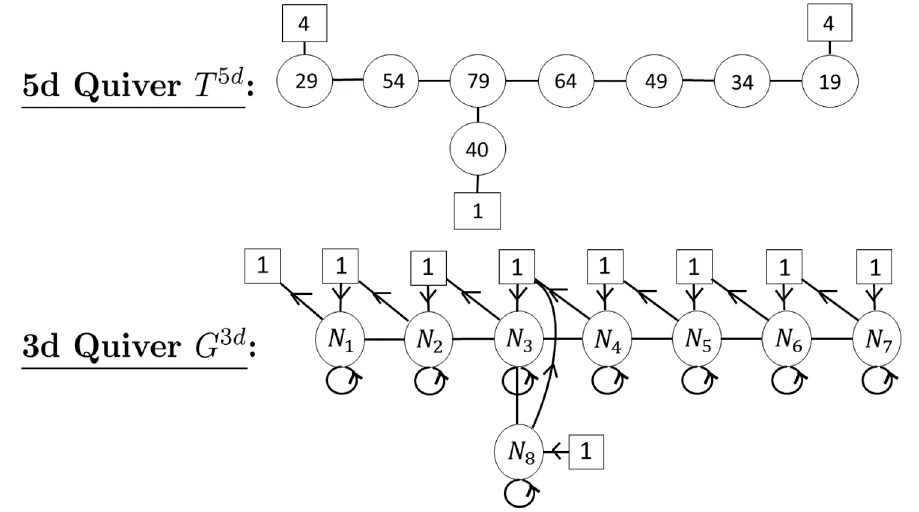
Figure 6. Sphere with 3 full E 8 punctures: 5d theory T 5d and 3d theory G 3d resulting from W S .